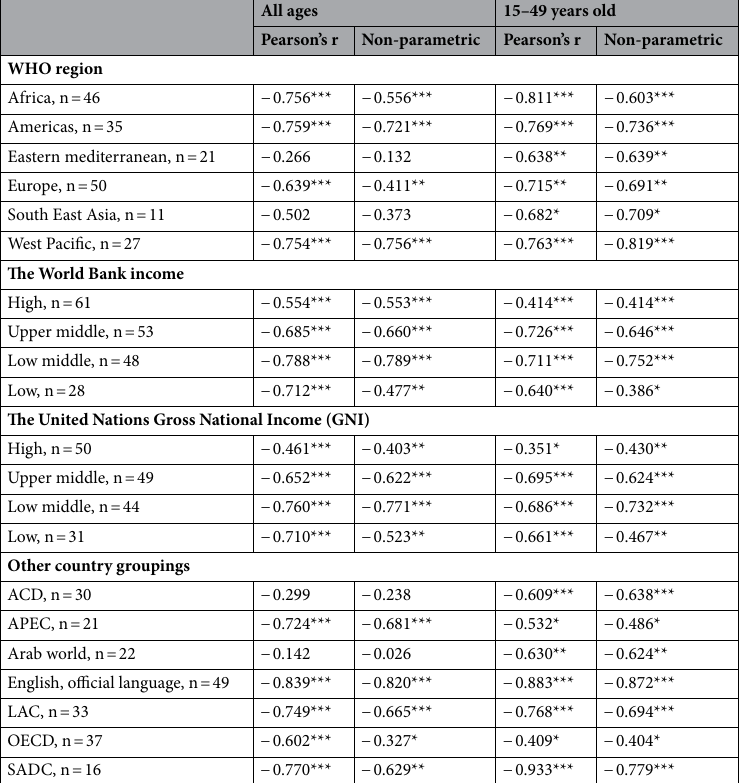
Table 4. Correlations between I s and dementia incidence in various country groupings. Significance level: * p < 0.05; ** p < 0.01; *** p < 0.001. Data sources: Dementia Incidence expressed as the number of new onsets of Alzheimer’s disease and other dementias published by the Institute for Health Metrics and Evaluation (IHME) in 2020; Opportunity for selection expressed as Is which was extracted from the previous publication by You et al. https:// doi. org/ 10. 1111/ eva. 12523. ACD Asia cooperation dialogue, APEC Asia–Pacific economic cooperation, LAC Latin America and the Caribbean, OECD organisation for economic co-operation and development, SADC Southern African Development